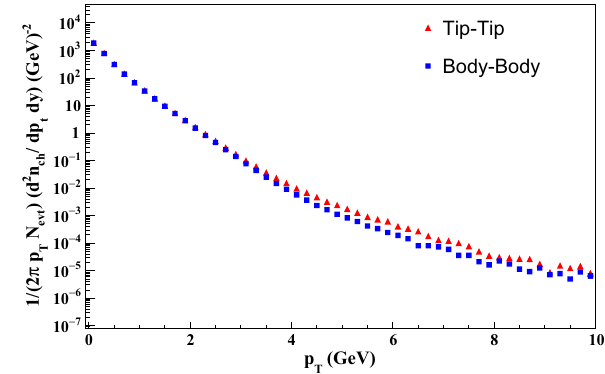
Fig. 18 Comparison of transverse momentum distribution of charged hadrons in tip–tip and body–body configuration for most central colli- sion